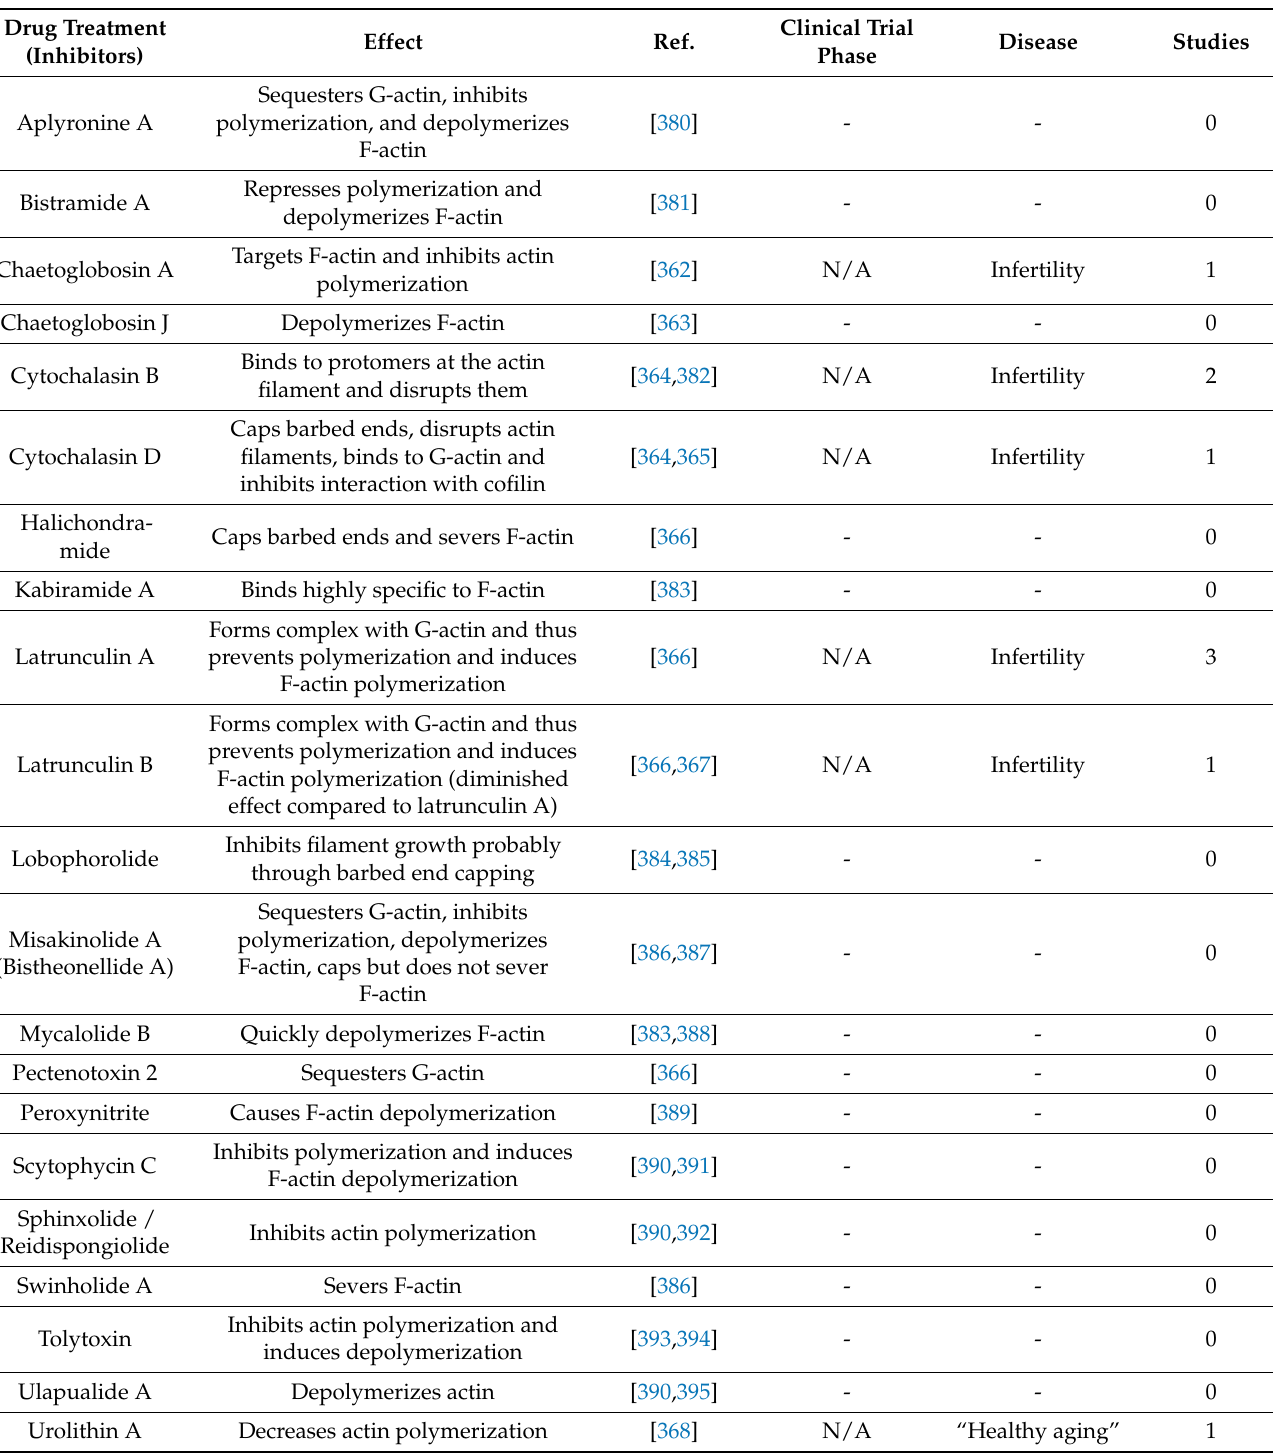
Table 2. The effects of inhibitors on the actin cytoskeleton and information on tests in clinical trials. The cited references describe the effect on actin; information on the clinical trials was collected from clinicaltrials.gov (accessed on 27 January 2021). N/A: not